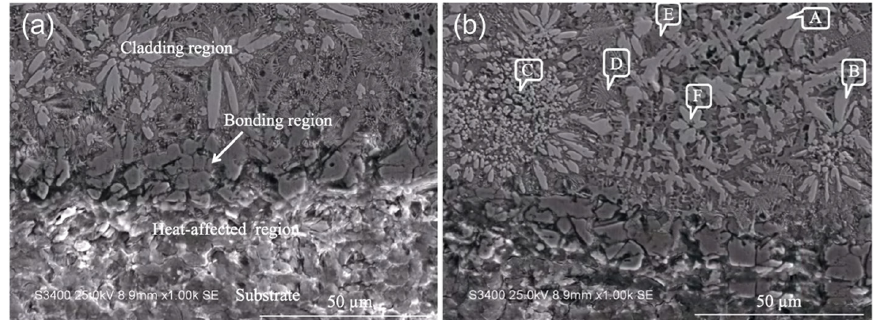
Figure 14. SEM images of bottom region of the cladding layer of sample: ( a ) Cross-section structure of cladding layer; ( b ) Microstructure of cladding layer (A. Fe 3 W 3 C; B. W 2 C, a few Fe 3 W 3 C and Mo 2 V 4 C 5 ; C. Fe 3 W 3 C, and WC; D. M 6 C type hard phase with Co element; E. Fe solid solution with a large amount of W and a small amount of Co, C, and other elements; F. Co 6 W 6 C) [60].